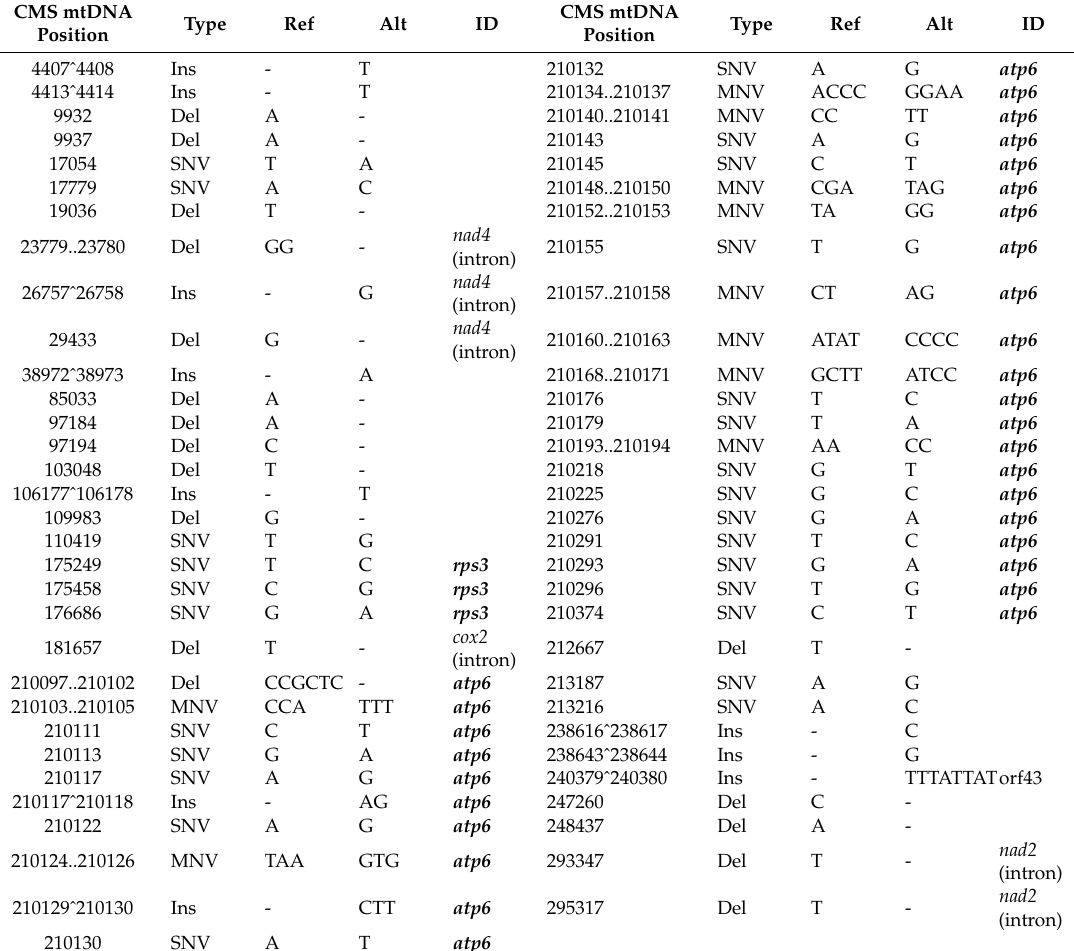
Table 1. Variant analysis results. Variant location in CMS mtDNA, variant type (Ins = Insertion, Del = Deletion, SNV = Single Nucleotide variant, MNV = Multiple Nucleotide Variant), reference allele (CMS), alternative allele (MF) and annotation (ID) are reported (bold indicates a variant located within the